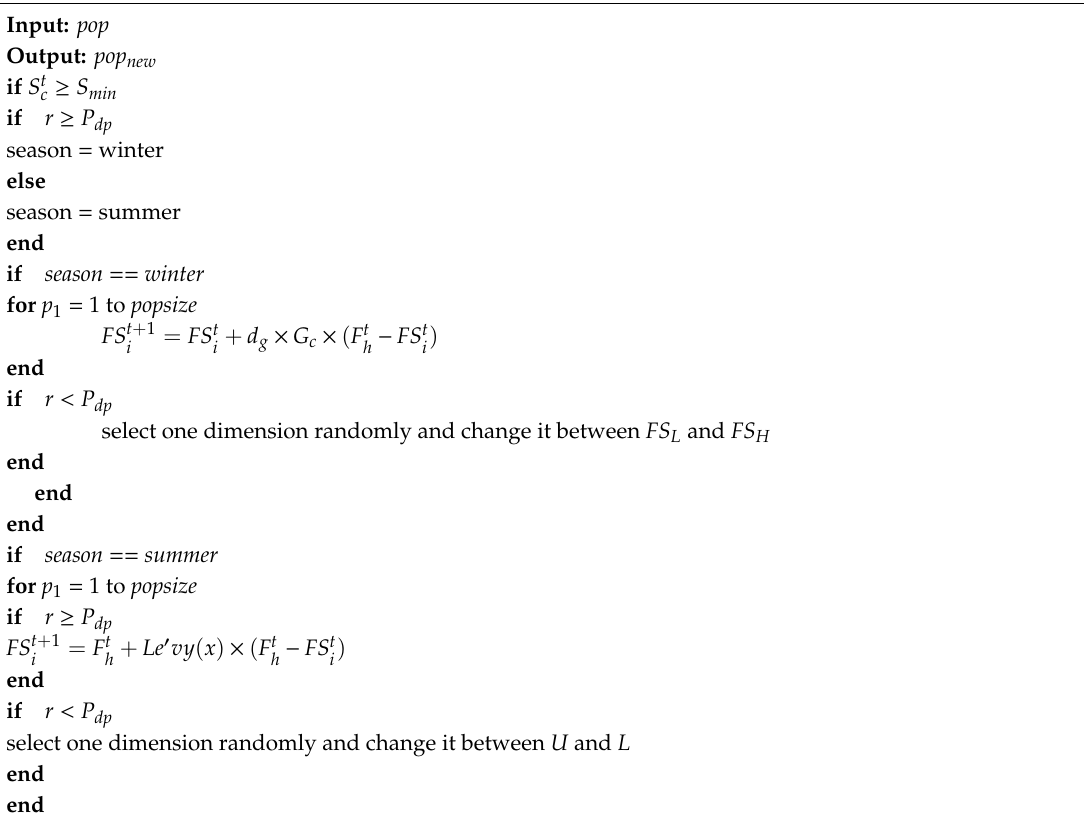
Algorithm 3. Pseudo Code of the Progressive Search